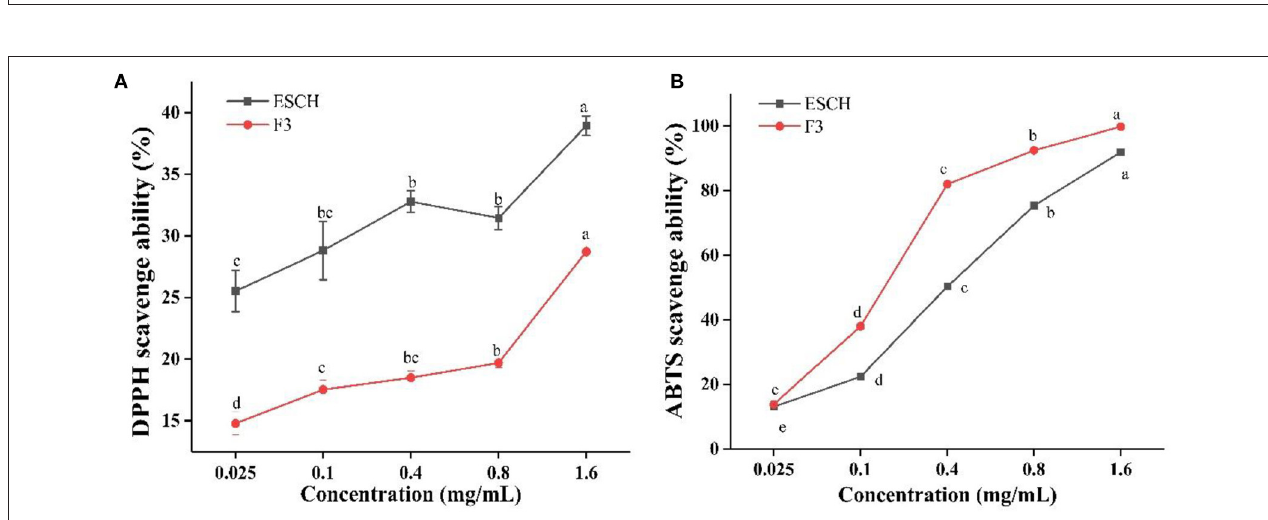
FIGURE 4 | DPPH (A) and ABTS (B) scavenge ability of ESCH and F3. The results were expressed as means ± SD ( n = 3), where lowercase letters indicate significantly different at p < 0.05.